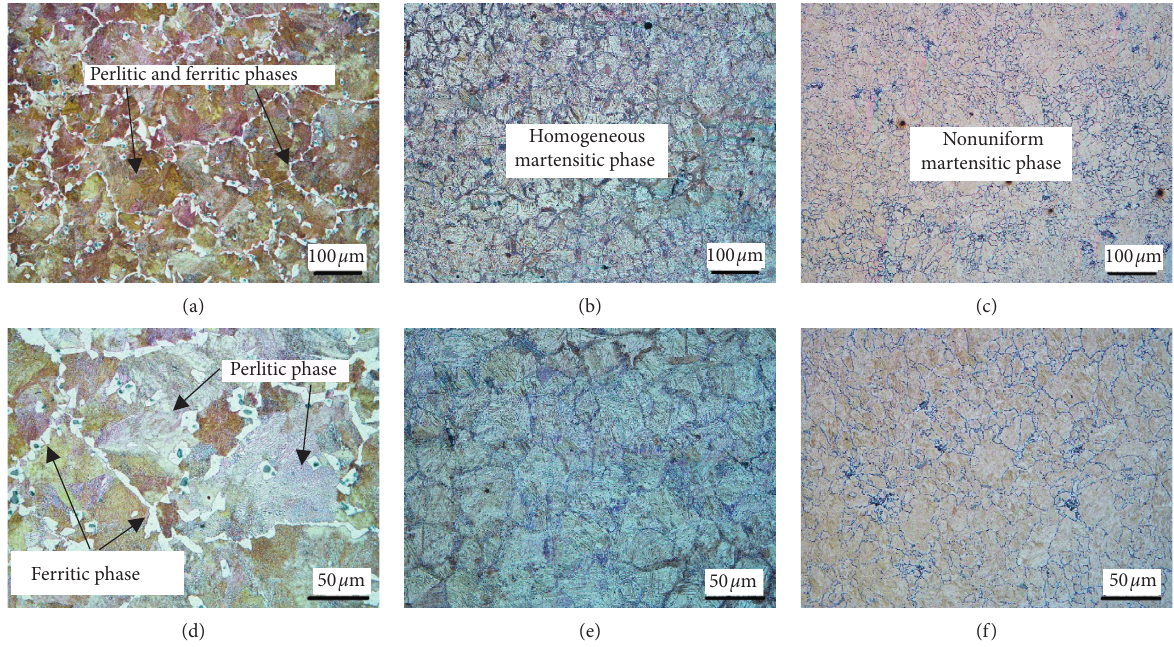
Figure 3: Grain morphology of the longitudinal section for (a) RAW sample, (b) LQ sample, and (c) CQT sample. Higher magnification images show (d) perlitic and ferritic phases for RAW material, (e) homogeneous martensitic phase, and (f) nonuniform martensitic